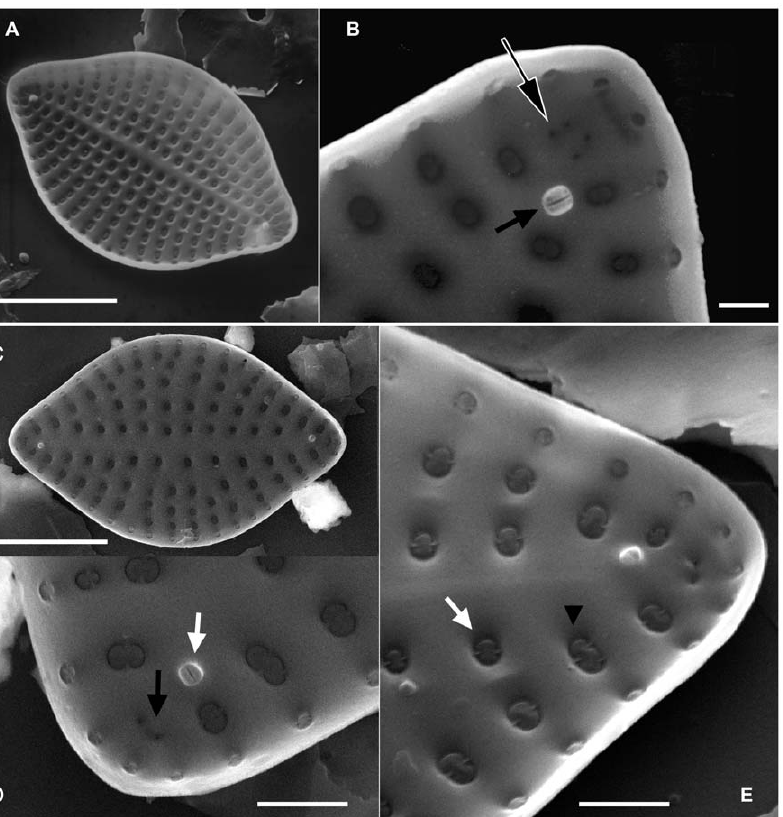
Figure 3. Internal valve views of Meloneismimallis sp. nov. and Meloneisakytos sp. nov. under SEM. Figure 3A. M. mimallis with diagonally positioned rimoportulae in relation to the apical axis. Figure 3B. Detail of the apex showing the elongated slit-like internal opening of the rimoportula (black arrow), and the pseudocellus consisting of 4 fine pores (black arrow with white outline). Figure 3C. A specimen of M. akytos with distant striae and diagonally positioned rimoportulae in relation to the apical axis. Figure 3D. M. akytos showing the elongated slit-like internal opening of the rimoportula (white arrow), and the pseudocellus with 2 fine pores (black arrow). Figure 3E. Tilted specimen of M. akytos ; note the two (white arrow) or three (black arrowhead) struts of the rotae in the areolae. [Scale bars: Figures 3A, C=10 m m, Figure 3B=1 m m, Figures 3D, E=2 m m].